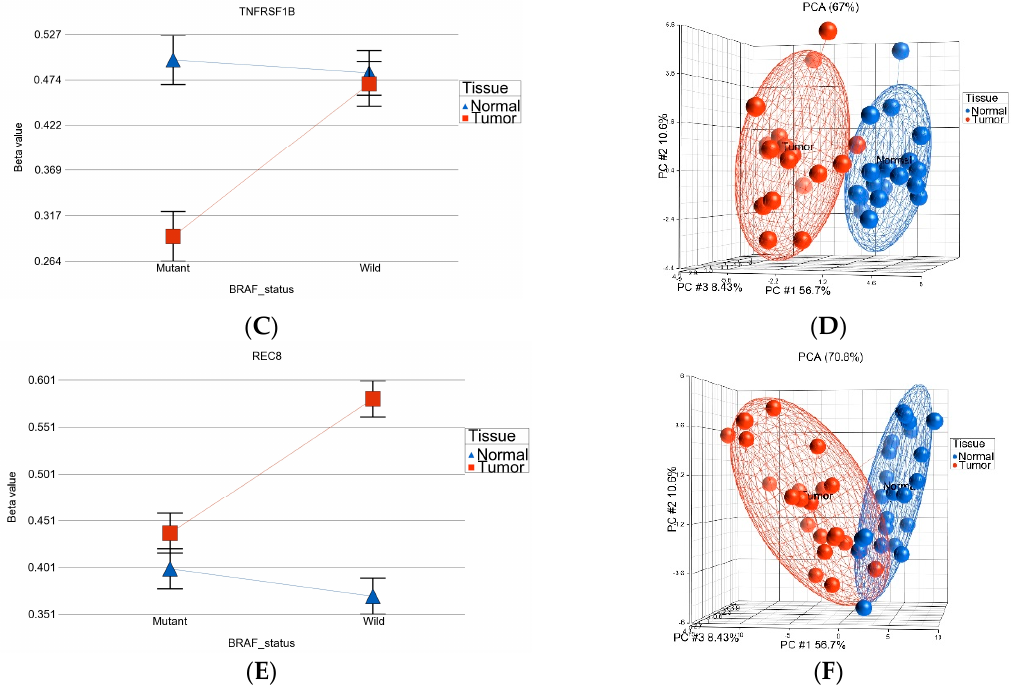
Figure 4. Three sets of DML in thyroid cancer. Examples of one locus from each set are shown on the left side (ACE), and the PCA plots from all the DML of each set are shown on the right side ( B , D , F ). The top panel ( A , B ) represents the 51 DML common in BRAF mutant and BRAF wild-type tumors, where ( A ) shows an example of this group— CCND1 was significantly hypomethylated in tumor tissue compared to normal tissue, and the magnitude of differential methylation in BRAF mutant and wild-type was not different (interaction p > 0.05); ( B ) shows separation of the tumor tissue and normal tissue based on these common 51 DML. The middle panel ( C , D ) represents the BRAF mutation-specific 35 DML; the lower panel ( E , F ) shows the BRAF wild-type-specific 62 DML.